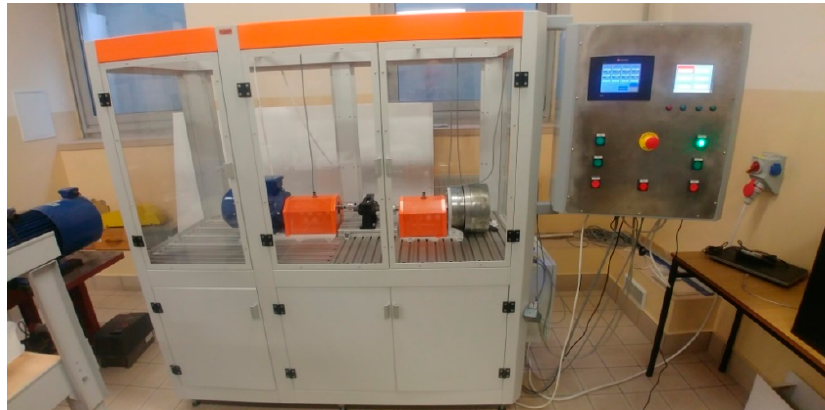
Figure 5. Fatigue test rig for polymer gears.